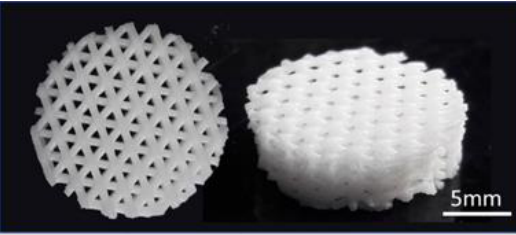
Figure 18. 3D printed scaffolds of BG-alginate composites for direct cell biological characterization with a height of 2.8 mm and a diameter of 15 mm with an inter-layer angle change from 0° to 60° and interconnected pore system. Top view ( left ), side view ( right ).